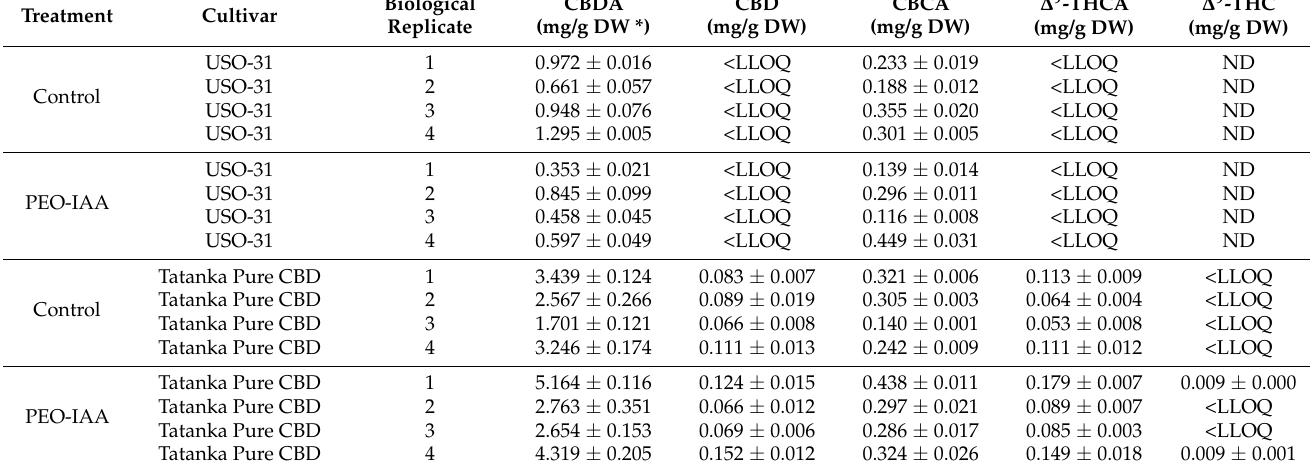
Table 2. Phytocannabinoid concentrations (mg/g DW) in samples of the cultivars ‘USO-31’ and ‘Tatanka Pure CBD’ and comparison of the content in the plants cultivated in the medium with PEO-IAA and control plants. All other cannabinoids not included in the table were in concentrations less than 0.009 mg/g DW (except for CBDVA (<0.03 mg/g), CBDA (<0.05 mg/g), CBGA (<0.18 mg/g), and CBC (<0.02 mg/g)). Values represent the means ± SD (n = 3).